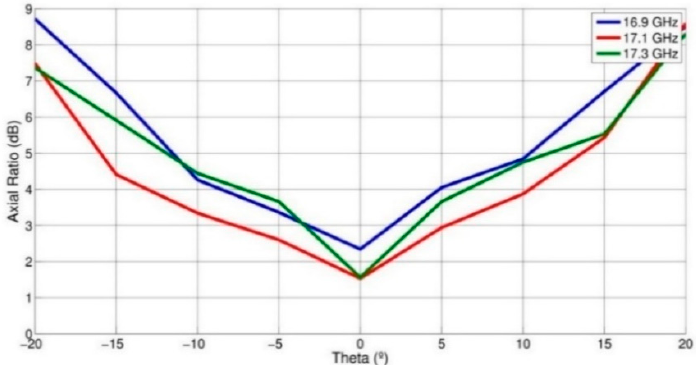
Figure 3. Simulated axial ratio of the implemented patch array (LHCP) vs the angle of the direction, for three frequencies covering the operating band.